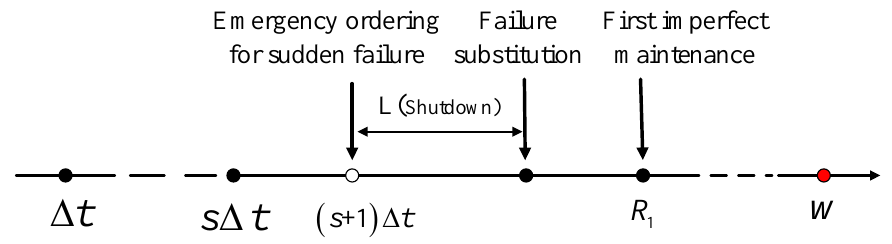
Figure 5. Failure replacement and spare parts ordering process 1.